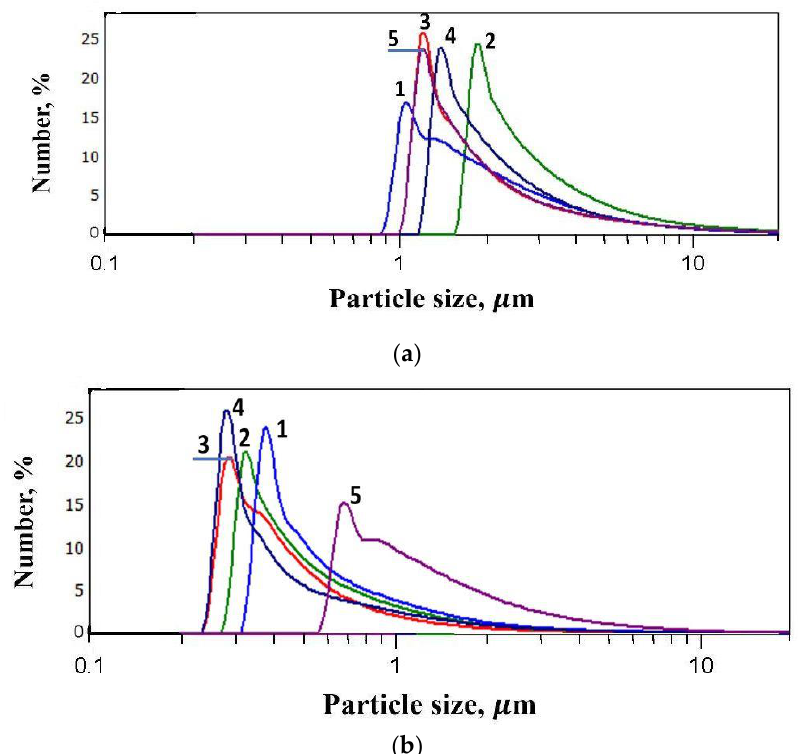
Figure 4. Results of measurements of the dispersion of FLG particles in a photopolymer resin. ( a ) — without ultrasonic treatment, 1 — 0.25 wt. %, 2 — 0.5 wt. %, 3 — 1 wt. %, 4 — 2 wt. %, and 5 — 4 wt. %; ( b ) — ultrasonic treatment at 50 °C, 1 — 0.25 wt. %, 2 — 0.5 wt. %, 3 — 1 wt. %, 4 — 2 wt. %, and 5 — 4 wt. %.